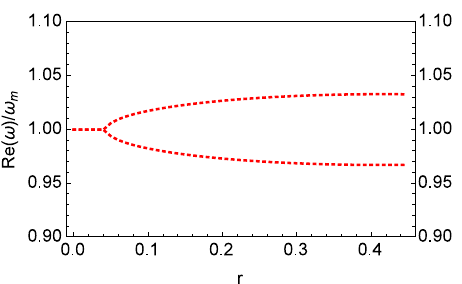
Figure 3. The real parts of the solutions of d ( ω ) = 0 in the domain Re ( ω ) > 0 versus the reflection coefficient r of the beam splitter.